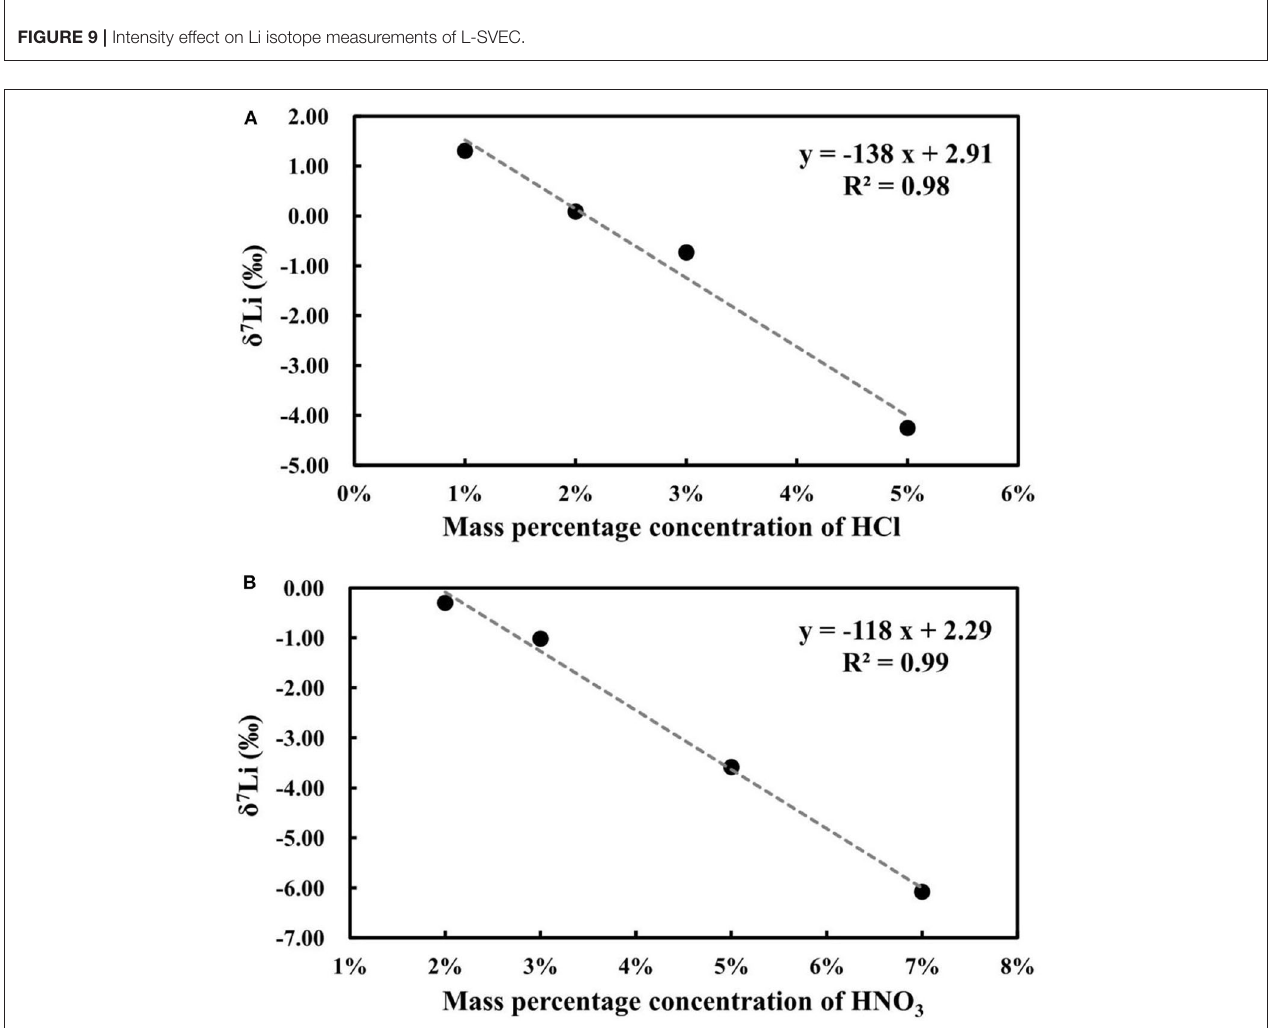
FIGURE 10 | (A) The effects of HCl matrix on Li isotope measurement; (B) The effects of HNO3 matrix on Li isotope measurement.